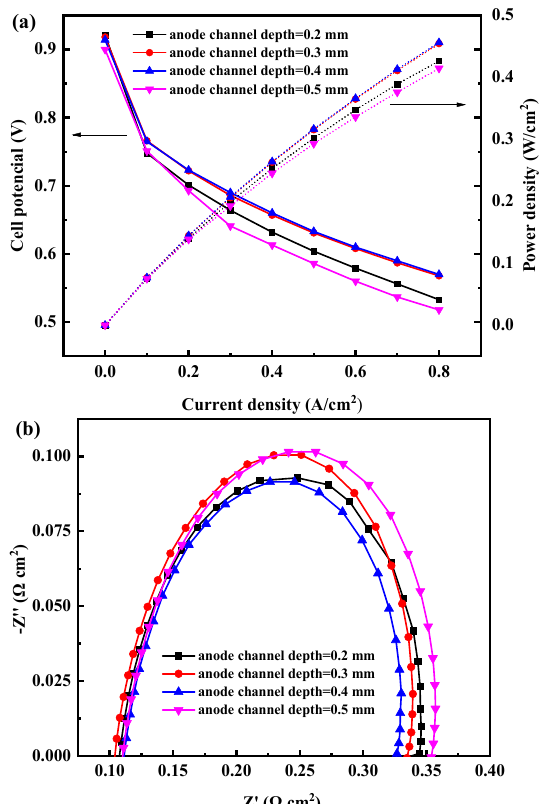
Figure 5. ( a ) Polarization and ( b ) power density curves of the open-cathode PEMFC with different anode serpentine channel depths.